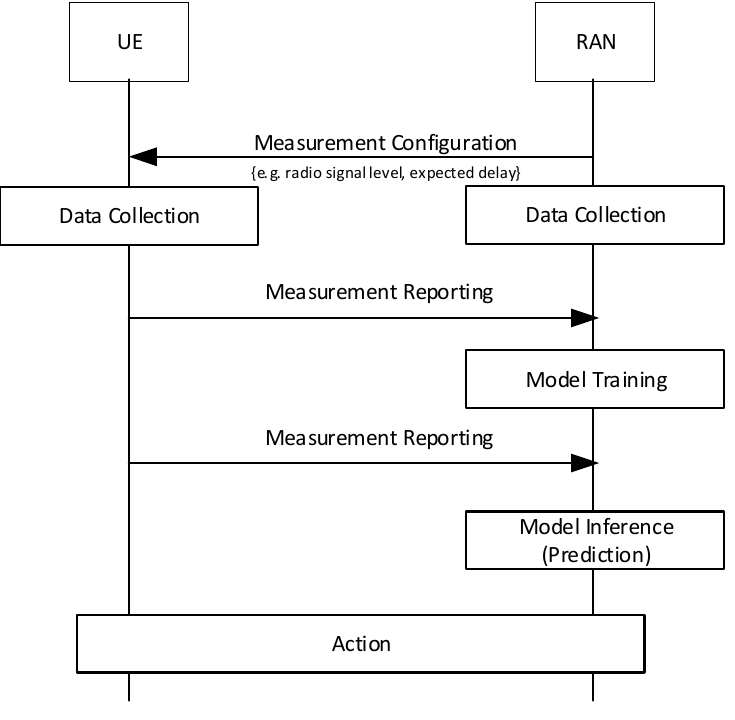
Figure 5. RAN signaling for ML-based operations.